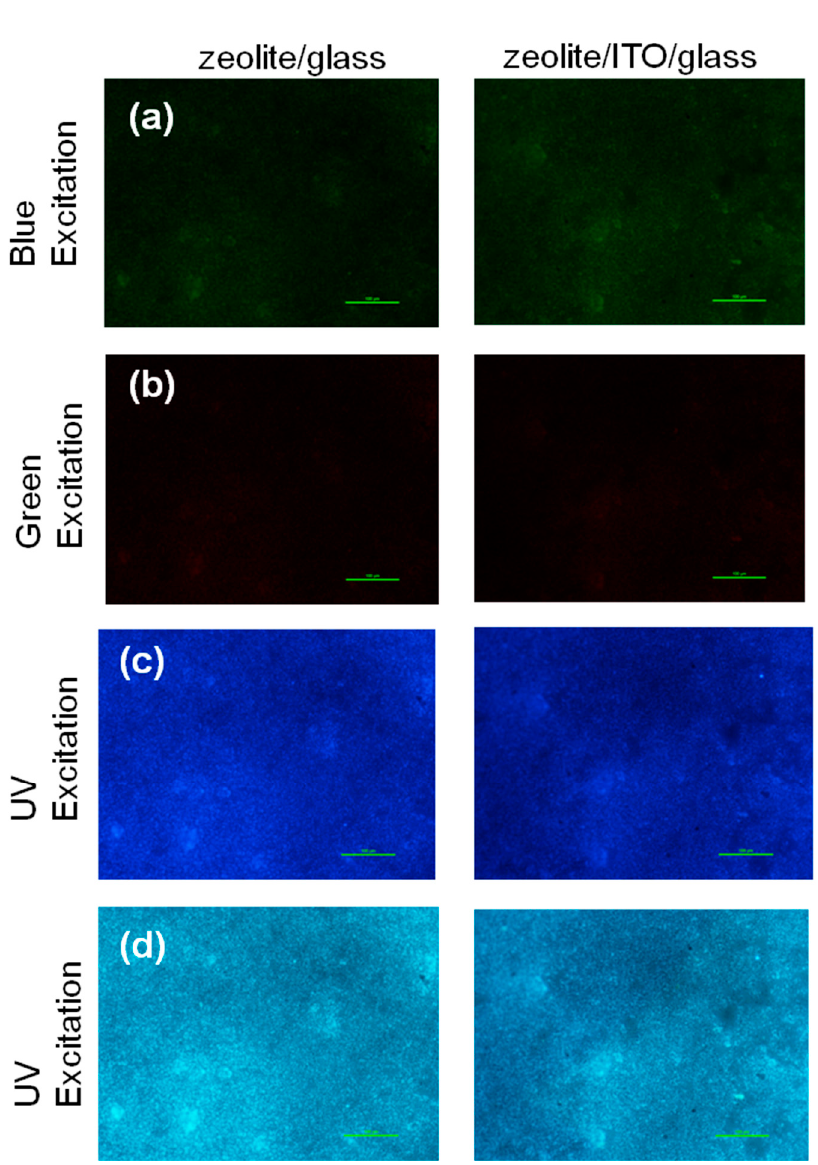
Figure 7. Fluorescence microscopy images of the zeolite/glass and zeolite/ITO/glass under blue ( a ), green ( b ) and UV excitations ( c , d ). The images ( a – c ) were obtained through the band-pass filters of different wavelengths; the images ( d ) were captured within visible range (scale bar—100 μ m).